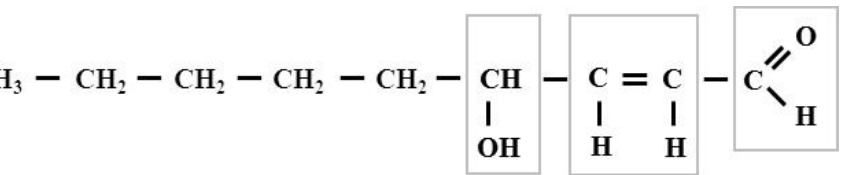
Figure 1. The formula of 4-hydroxy-2,3-trans-nonenal. The squares indicate the reactive groups of this compound. The cis-aldehydes are not stable, they are easily cyclized to